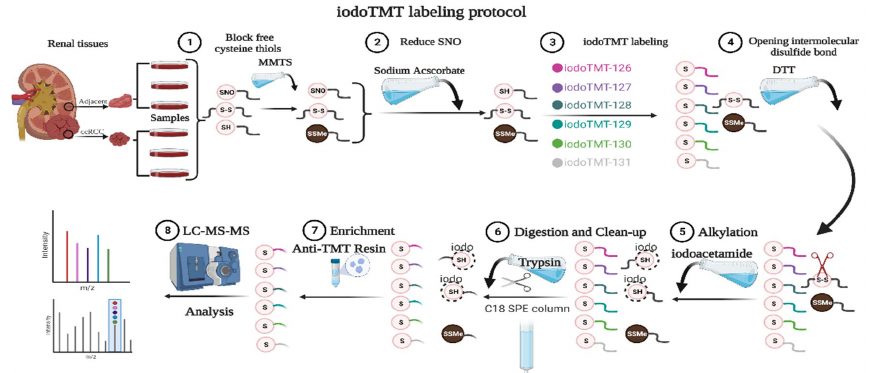
Figure 1. SNO-proteome protocol. MMTS: methylmethanethiosulfonate; SNO: protein S-nitrosylation; iodoTMT: iodoacetyl tandem mass tag; DTT: Dithiothreitol; LC-MS-MS: liquid chromatography-tandem mass spectrometry.